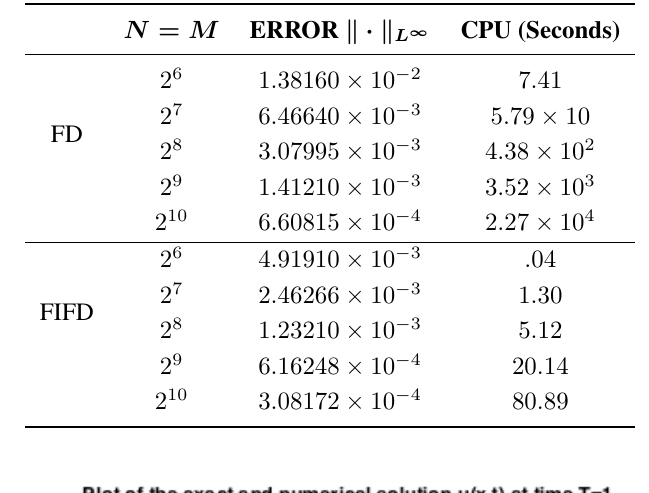
Table 1. Comparison of the fast iterative finite difference (FIFD) method with the regular finite difference (FD) method in the simulation of the fractional diffusion problem with a known analytical solution.